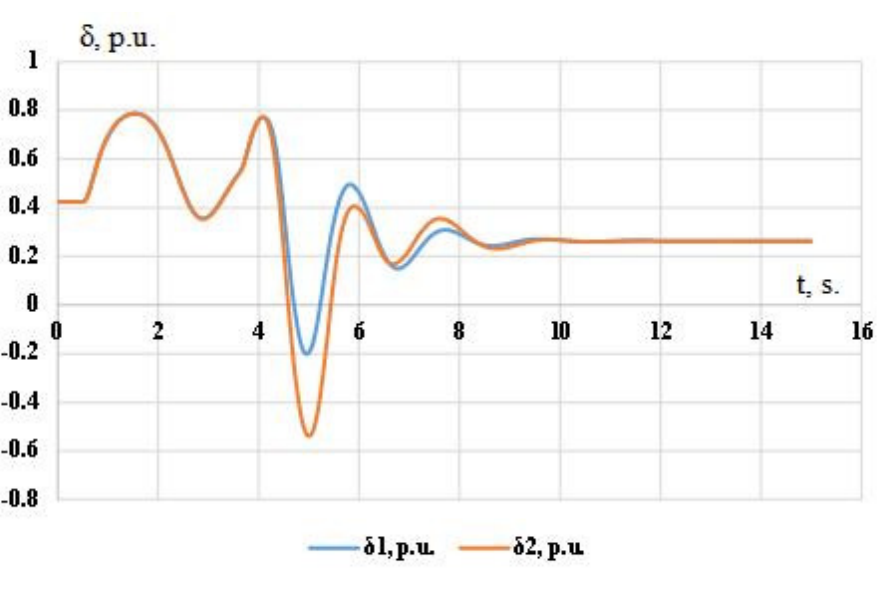
Figure 23. Generator G 2 Figure 24. Generator G 2 angle.